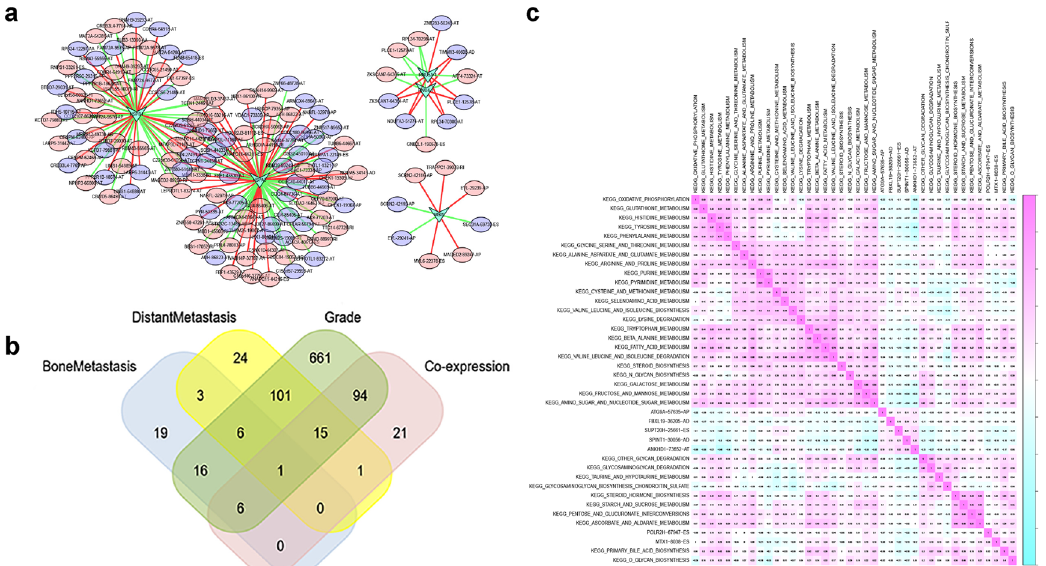
Fig. 3 Construction of prognostic AS regulation network. The network constructed for splicing factors and overall-survival-associated splicing events ( a ). Venn plot showed the relationship between overall-survival-associated splicing events and bone metastasis/distant metastasis/grade/co-expression ( b ). Gene set variation analysis (GSVA) showed the co-expression of Kyoto Encyclopedia of Genes and Genomes (KEGG) pathways and overall-survival-associated splicing events related to metastasis ( c